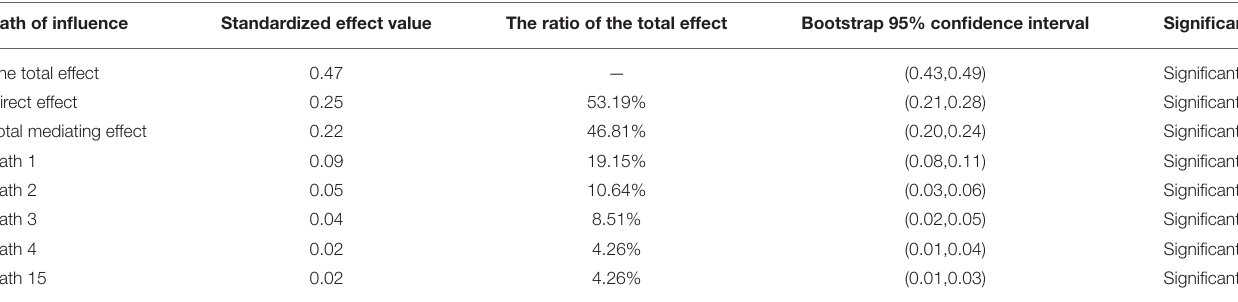
TABLE 4 | Mediation effect